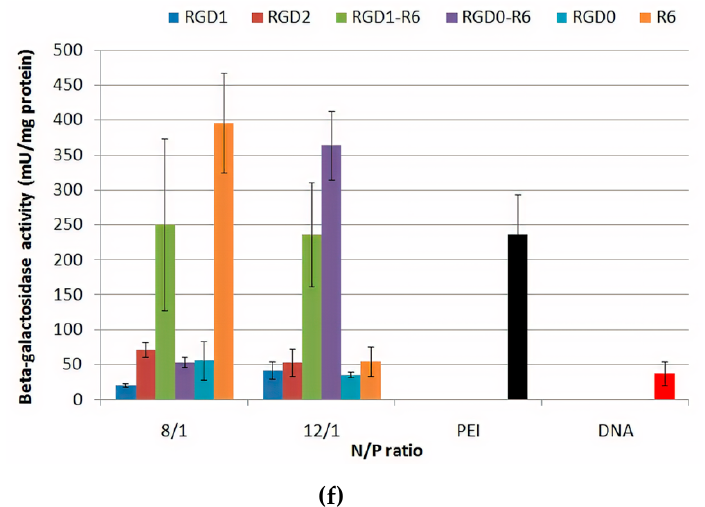
Figure 7. Uptake and transfection efficacy evaluation of RGD1-R6 and RGD0-R6-polyplexes in PANC-1 cells using ( a ) YOYO-1-labeled pDNA, ( b , c ) pCMV-lacZ plasmid and ( d ) pEXPR-IBA5-eGFP plasmid; ( e ) competition assay with free cyclic (RGDfK) peptide and RGD1-R6/DNA or RGD0-R6/DNA complexes at N/P ratios of 8/1 and 12/1 in PANC-1 cells; ( f ) transfection efficacy evaluation of RGD1-R6 and RGD0-R6-polyplexes in 293T cells using pCMV-lacZ plasmid. Values are the mean ± SD of the mean of triplicates. * p < 0.05, ** p < 0.01—compared to the complexes as indicated.